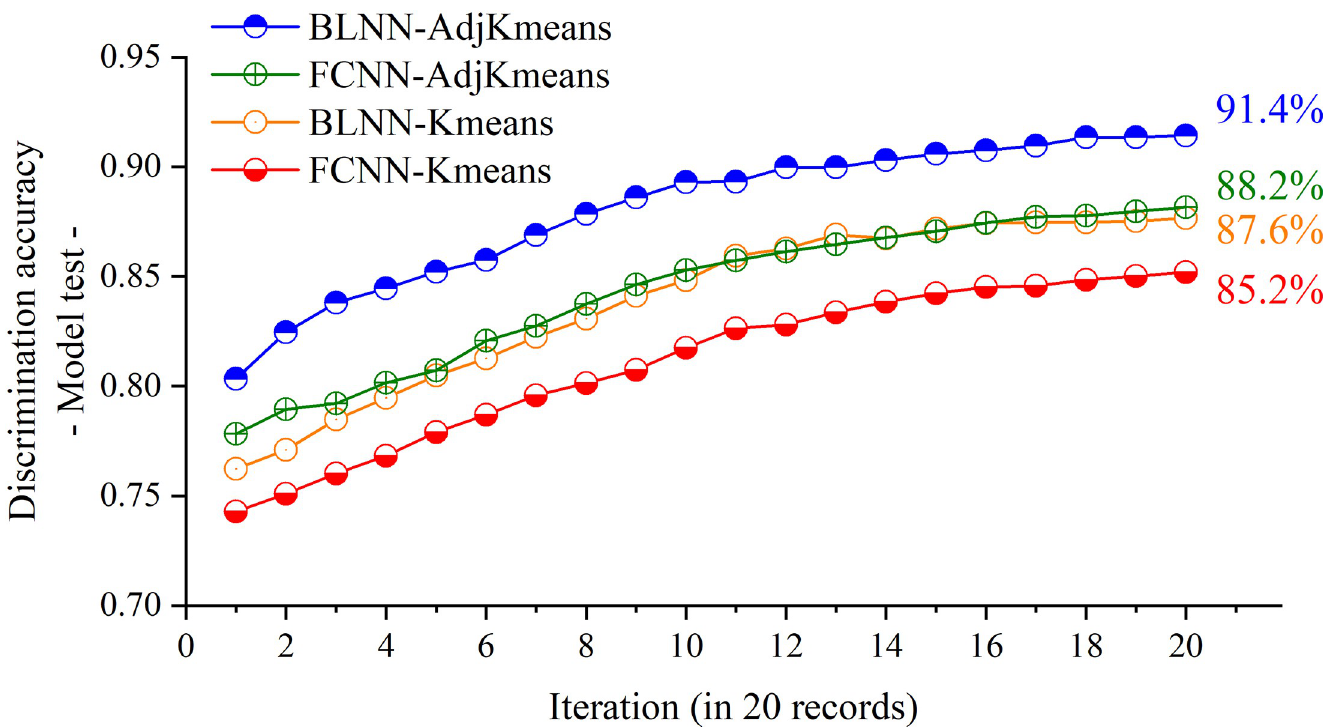
Fig 8. The 20 iterative records of the model improvement for the optimized BLNN–AdjKmeans model (blue) and the FCNN–AdjKmeans model (green), in comparison to the BLNN–Kmeans (yellow) and FCNN–Kmeans models (red). (Note that the label AdjKmeans represents the adjusted K–means method).